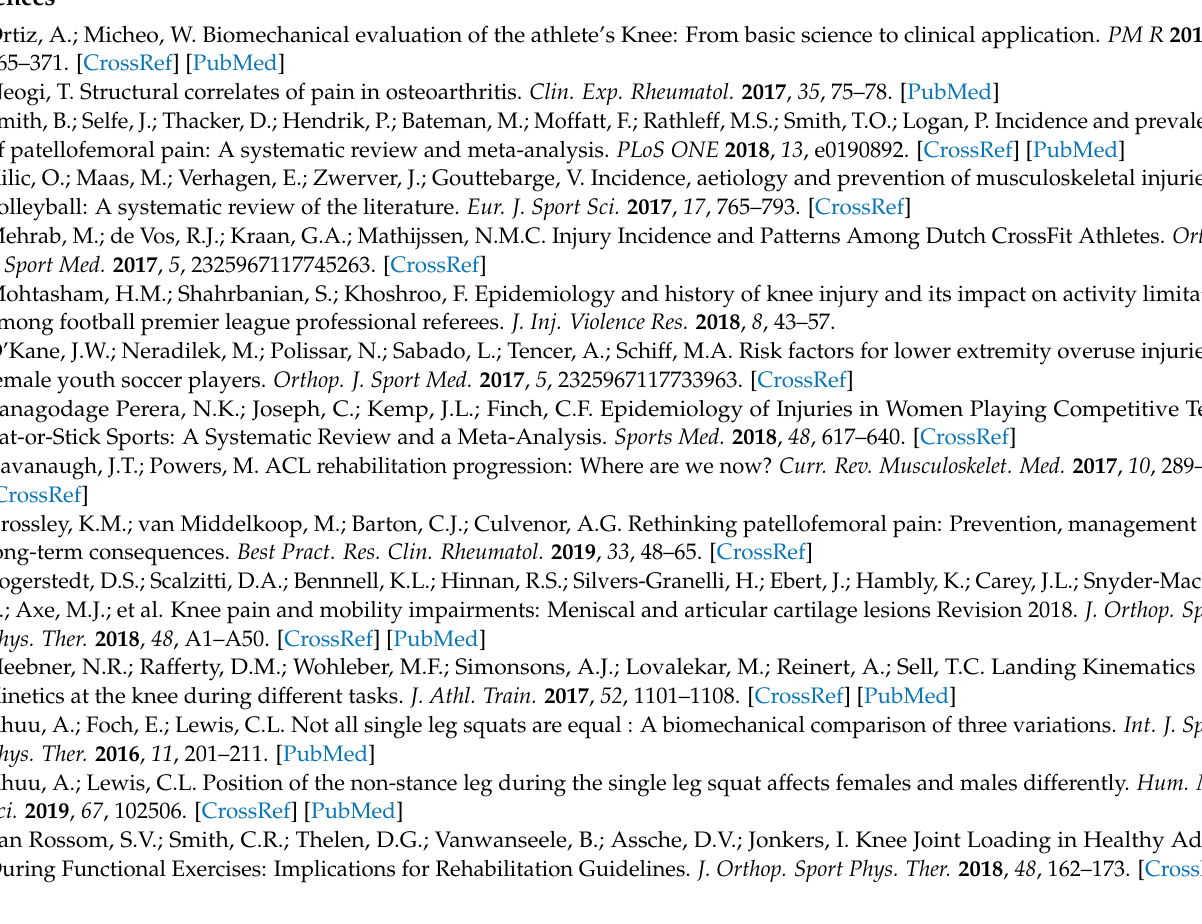
Table S2: Kinetics and kinematics of the knee stratified by sex: median and interquartile range of males (n = 15) and females (n = 15) in the single-leg weight-bearing tasks evaluated at the articular moment peak and angular peak of the knee; Table S3: Adjacent joints: kinetic and kinematic data of the adjacent joints at the moment of peak knee joint moment of the total sample (n = 30) and stratified by sex (male, n = 15; female, n =